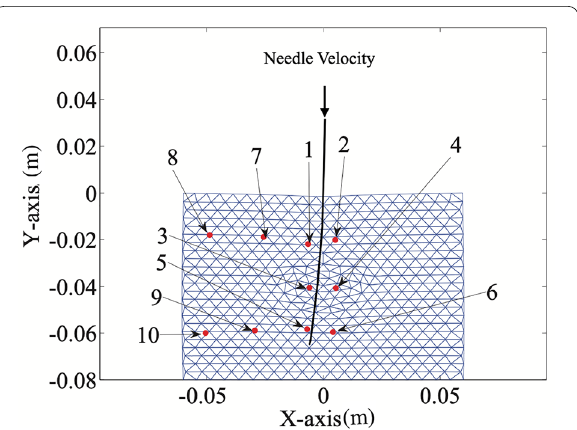
Figure 2 Ten observation points in the needle insertion procedure for the Kriging-based